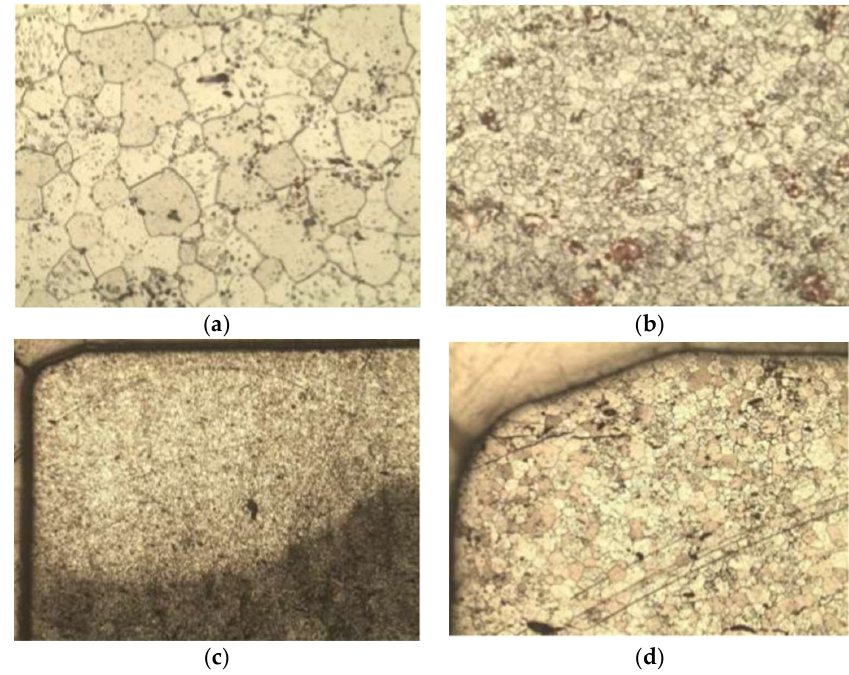
Figure 6. Photos of microstructure of pellet sintered in vertical position (1600 °С, 120 min), at different magnifications: ( a ) grain, lower part of the pellet, 500×; ( b ) grain, upper part of the pellet, 500×; ( c ) thin section after etching, 25×; ( d ) delamination, 100×.